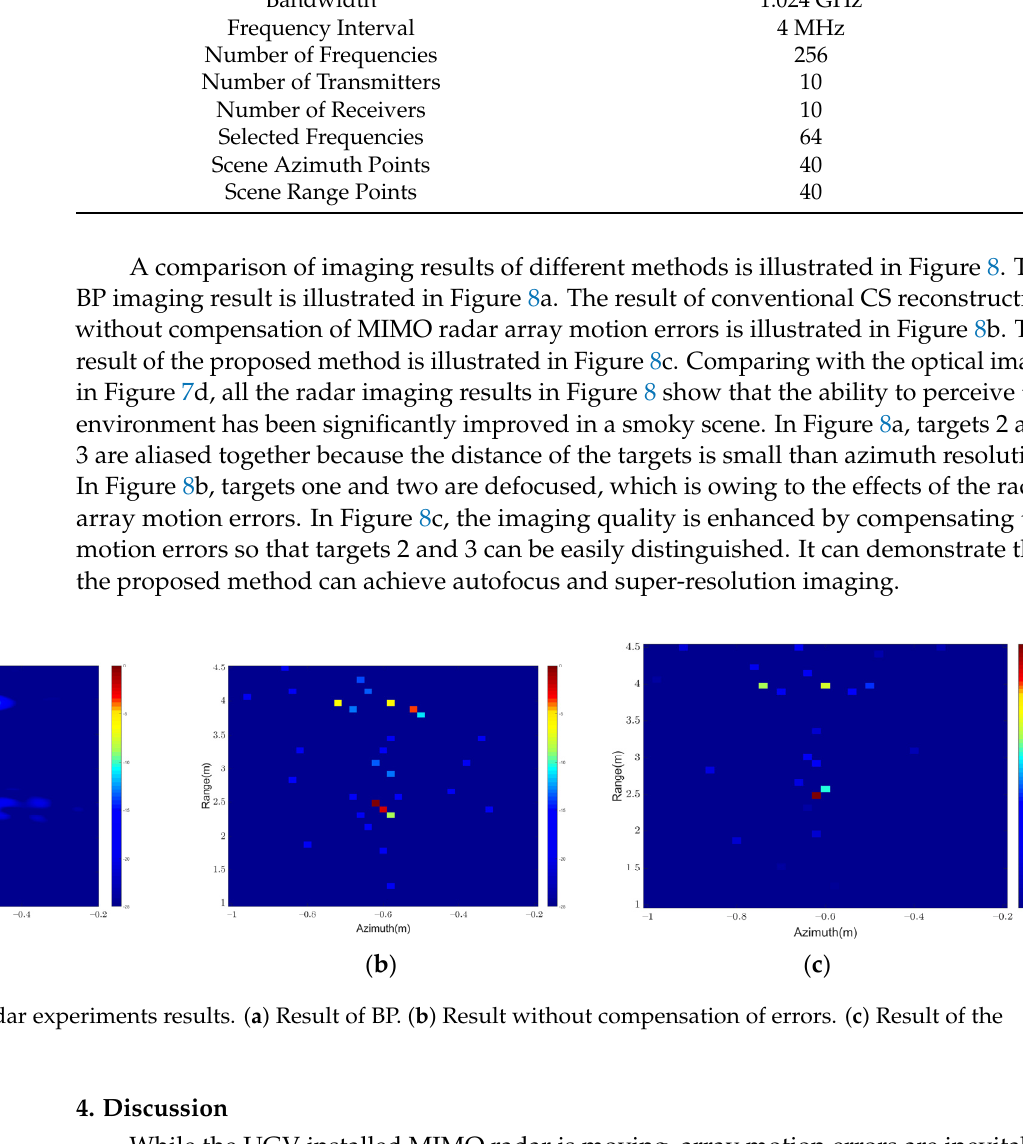
Table 4. Experimental parameters for MIMO radar.